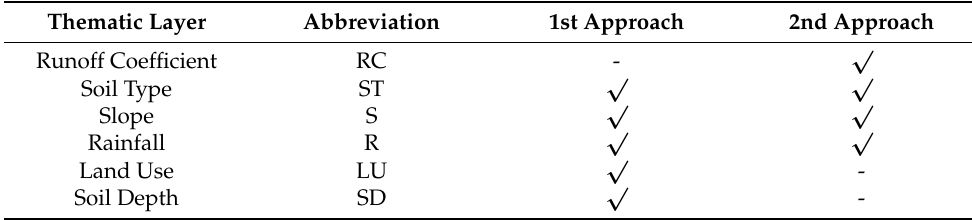
Table 1. The criteria used in